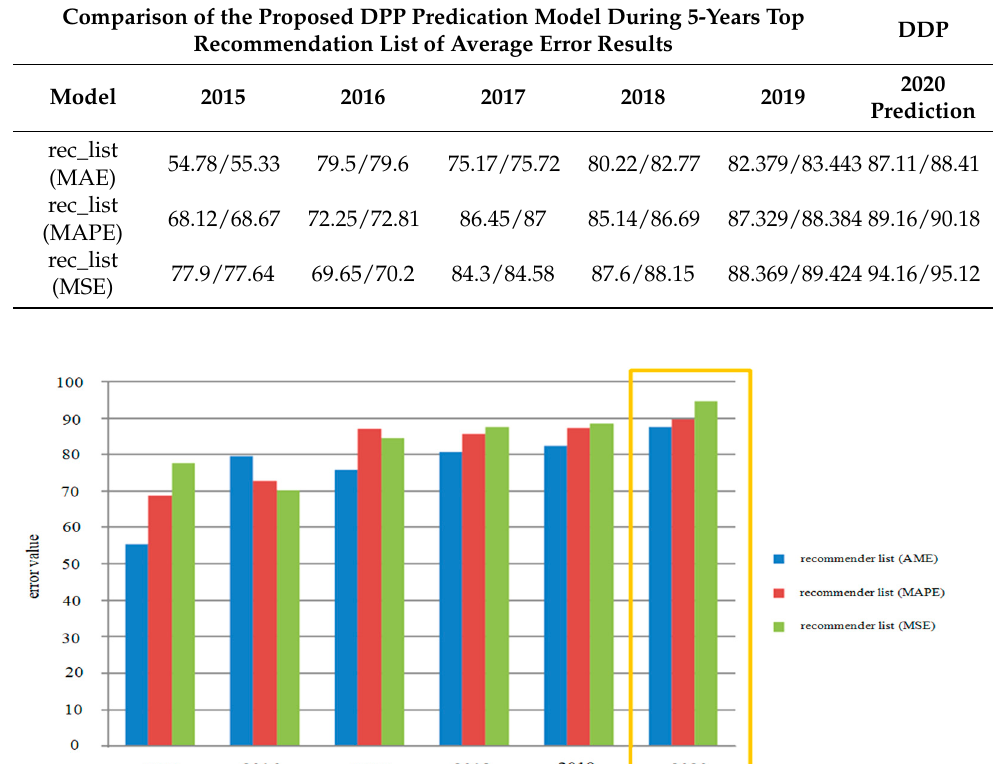
Table 9. Performance analysis of average error value and predication accuracy.